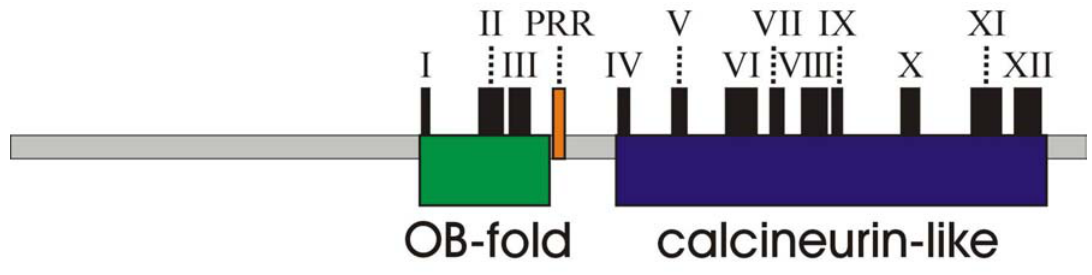
FIGURE 2. General structure of the Pol-associated B subunits. The location of the conserved motifs is indicated on top and marked with Roman numerals. PRR designates the proline-rich region between motifs III and IV. Below, the domain architecture of the B subunits is